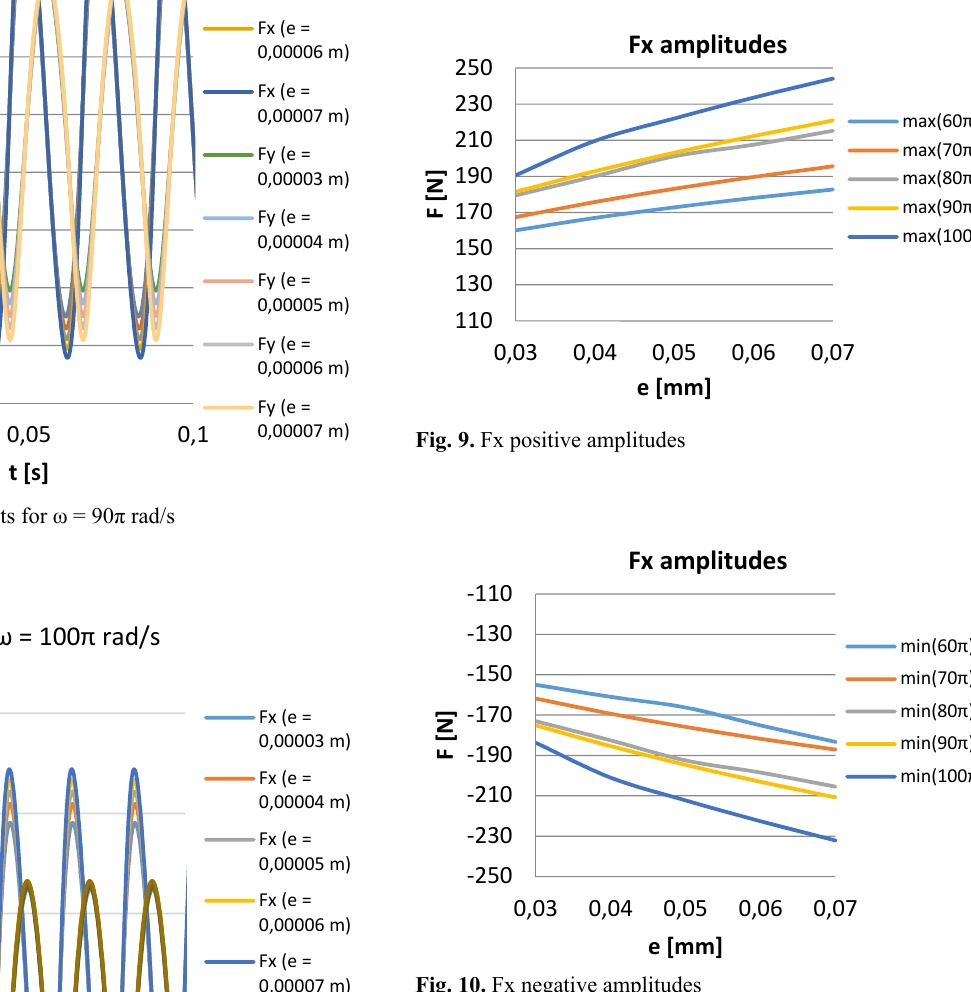
Fig. 10. Fx negative amplitudes